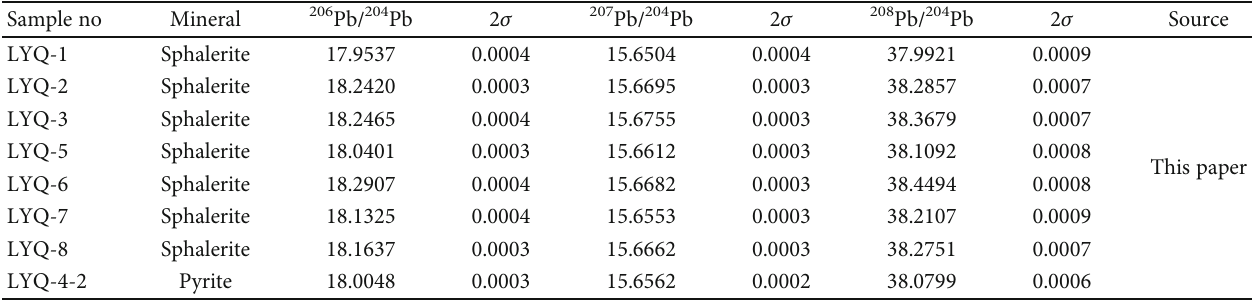
Figure 7: Comparison of sulfur isotopic compositions between the Laoyingqing Pb – Zn deposit and the major deposits in the SYGT (modi fi ed from [26]). S isotope compositions of the Huize deposit are taken from Liu and Lin [6], Li et al. [76], Han et al. [52], and Zhang [15]; those of the Maoping deposit are taken from Liu and Lin [6] and Wang et al. [11]; those of the Maozu deposit are taken from Liu and Lin [6], Zhang [15], and Zhou et al. [12]; those of the Lehong deposit are taken from Zhang et al. [14]; those of the Daliangzi deposit are taken from Liu and Lin [6], Zhang [15], Wu [13], and Yuan et al. [77]; those of the Tianbaoshan deposit are taken from Liu and Lin [6], Zhang [15], Zhou et al. [17], Zhu et al. [78], and He et al. [79]; those of the Chipu deposit are taken from Zhang [15] and Wu [13]; those of the Shanshulin deposit are taken from Zhou et al. [54]; those of the Shaojiwan deposit are taken from Zhou et al. [55]; and those of the Tianqiao deposit are taken from Zhou et al. [8]. Table 5: Lead isotopic compositions of sul fi des from the Laoyingqing Pb – Zn